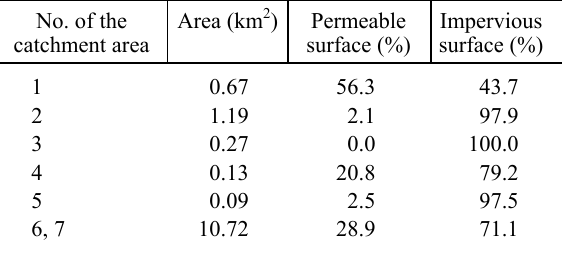
Table 1. Distribution of permeable and impervious surface areas in each catchment area